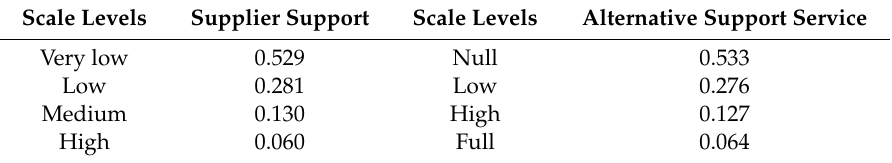
Table 12. Weightings of the scale levels of the descriptors of the criterion Availability of support. Scale